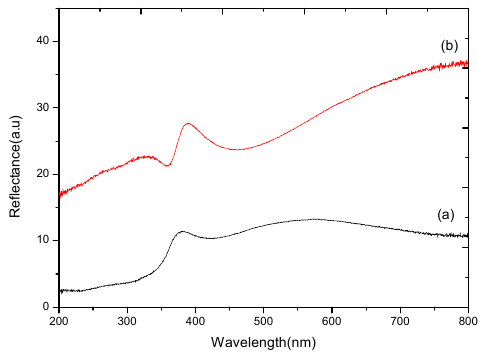
Figure 13. Reflectance vs. wavelength for ( a ) Cu ‐ 00 and ( b ) Cu ‐ 01.